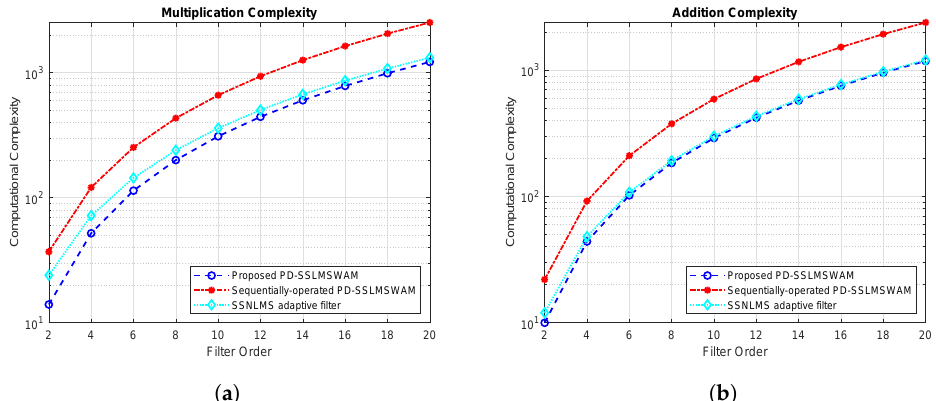
Figure 13. Computational complexity comparison among the proposed PD–SSLMSWAM, sequen- tially operated SSLMSWAM and SSLNLMS adaptive filters. ( a ) Multiplication complexity; ( b ) addi- tion complexity.